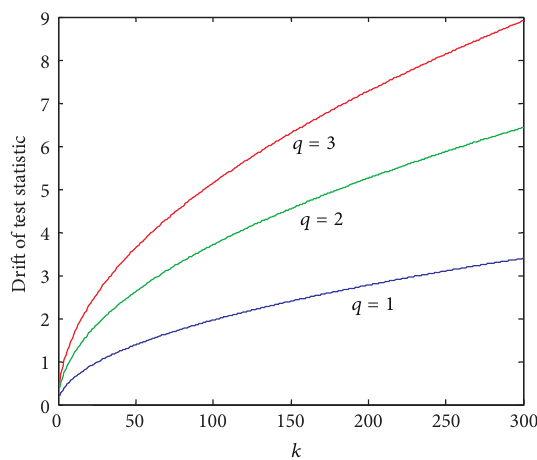
Figure 1: Drift of test statistic for 𝜎 = 5 and 𝑞 = 1, 2 , and